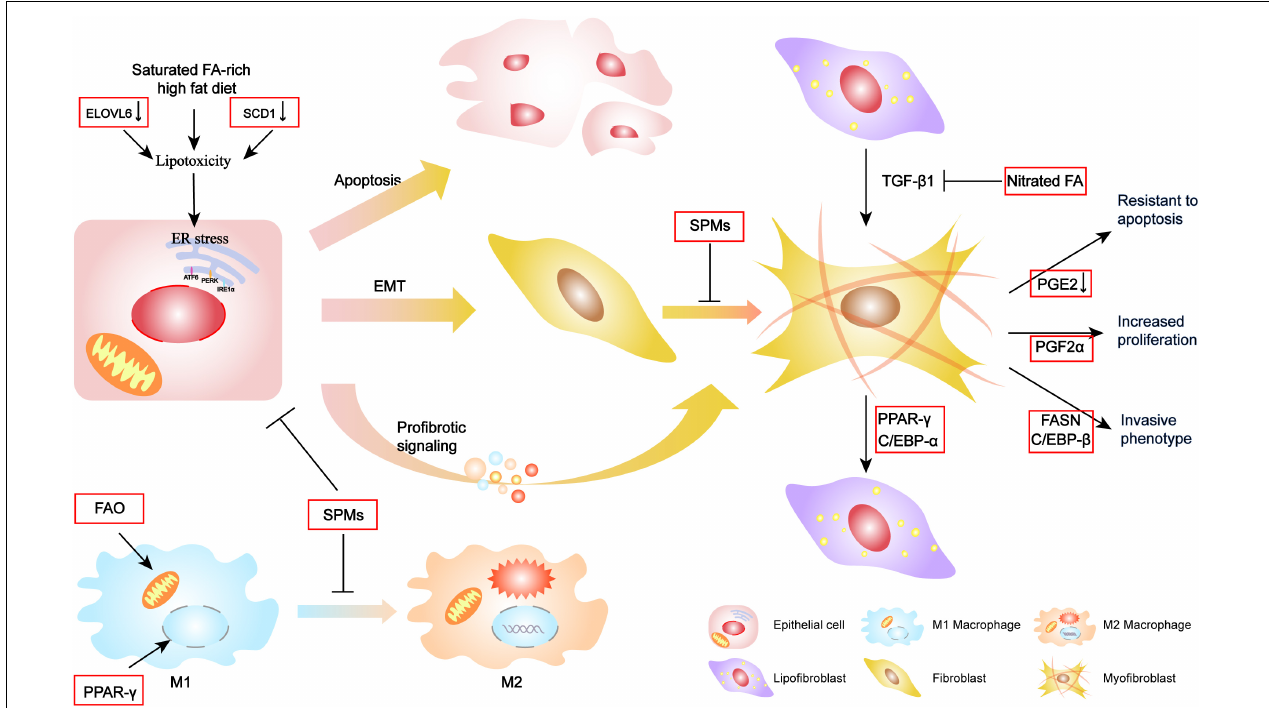
FIGURE 2 | Mechanism of FA metabolism contributing to the pathogenesis of IPF. Alterations in FA metabolism contribute epithelial cellular ER stress toward apoptosis, EMT, or secretion with profibrotic signaling, which further activates fibroblast differentiation. Increasing FAO and activation of PPAR- γ transcription factor may facilitate the transportation of some M2 macrophage target genes and promote M2 polarization. SPMs could protect these cellular endophenotypes changes and fibrotic molecular signature. Additionally, FA and the regulators are also involved in the reversible lipogenic-to-myogenic differentiation and directly contribute to myofibroblast proliferation, invasion, and resistance to apoptosis.